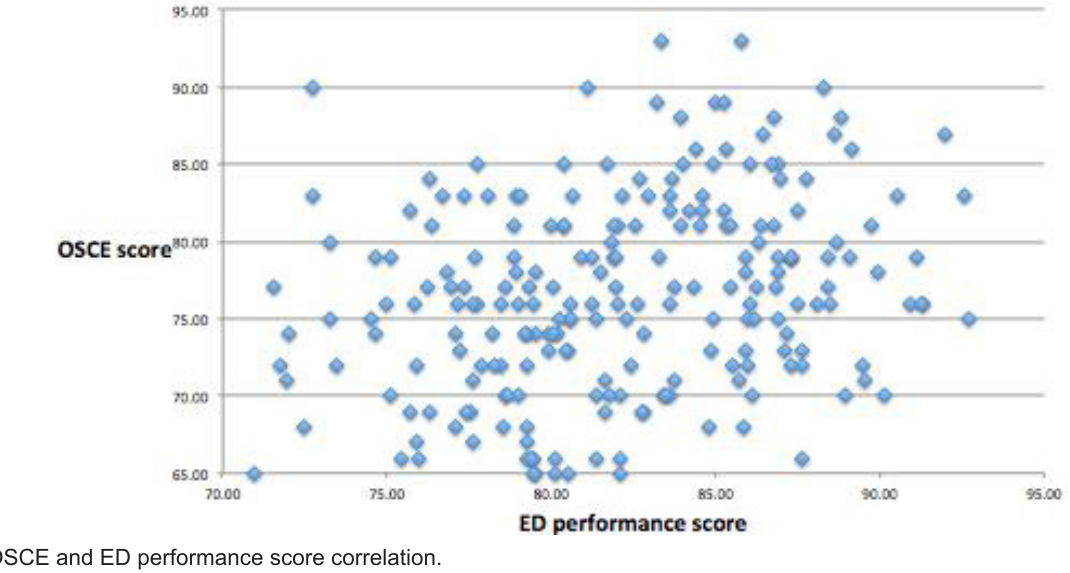
Figure 2. OSCE and ED performance score correlation.